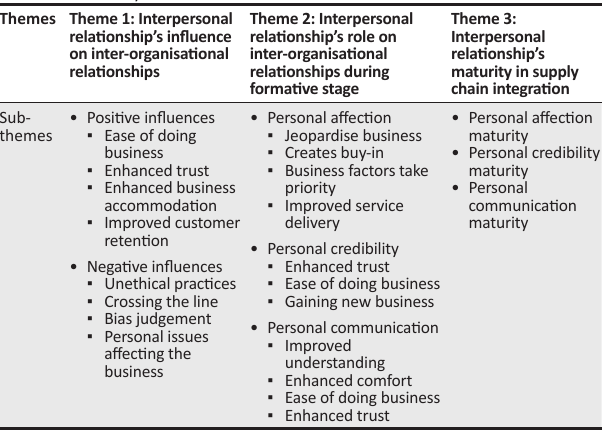
TABLE 2: Summary of themes. Themes Theme 1: Interpersonal relationship’s influence on inter-organisational relationships